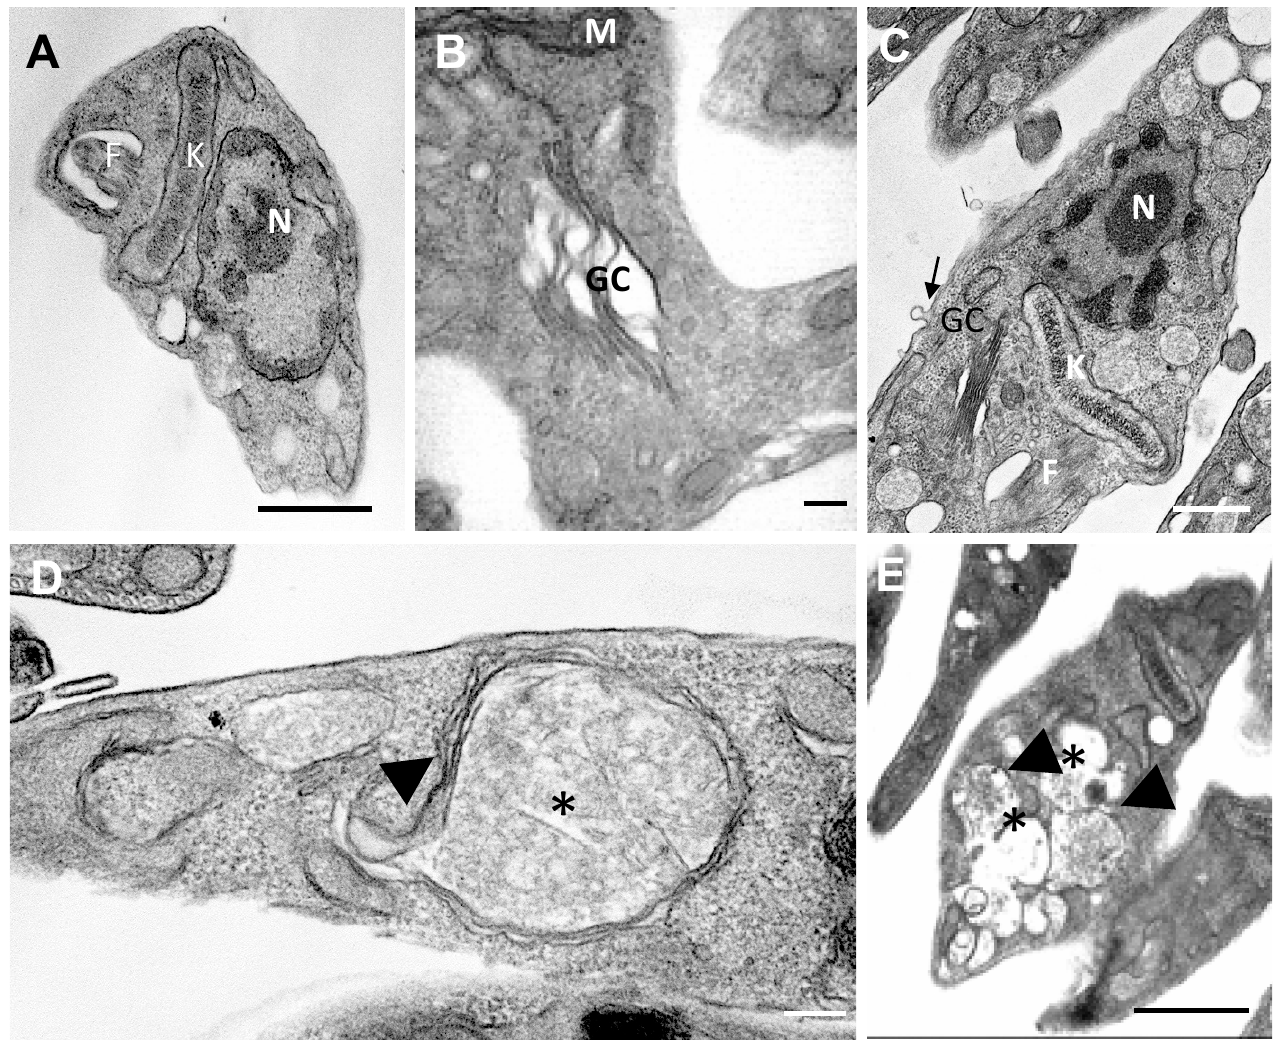
Figure 8. Transmission electron micrographs of T. cruzi epimastigotes treated with compound 27 (concentration = IC 50 calculated in epimastigotes) for 48 h. ( A ) The untreated control shows the preserved organelles. ( B – E ) Epimastigotes treated with 27 and disorganization of the Golgi complex ( B and C , GC), formation of autophagosome-like cytoplasmic vacuoles ( D and E , asterisks) surrounded by a membrane similar to the endoplasmic reticulum (arrowheads) and detachment of the membrane plasma (B—arrow). N = nucleus; K = kinetoplast; GC = Golgi complex; F = flagellum. Bars = 0.5 μ m.